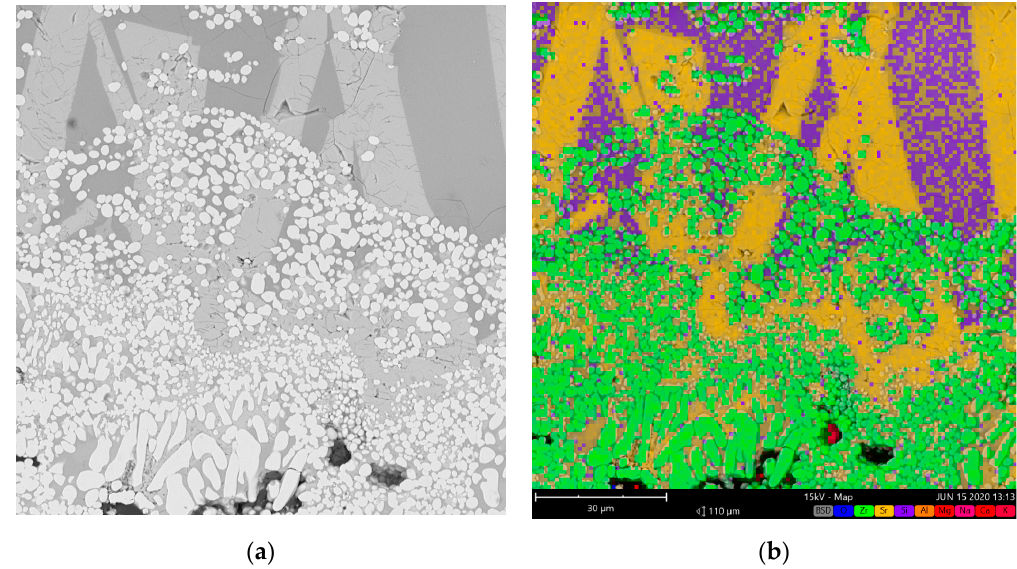
Figure 2. ( a ) SEM-BSE micrograph, sample 4 h; ( b ) Element map, sample 4 h. Scale bar 30 µm. Area of Figure 2 indicated on Figure 1b by red color.